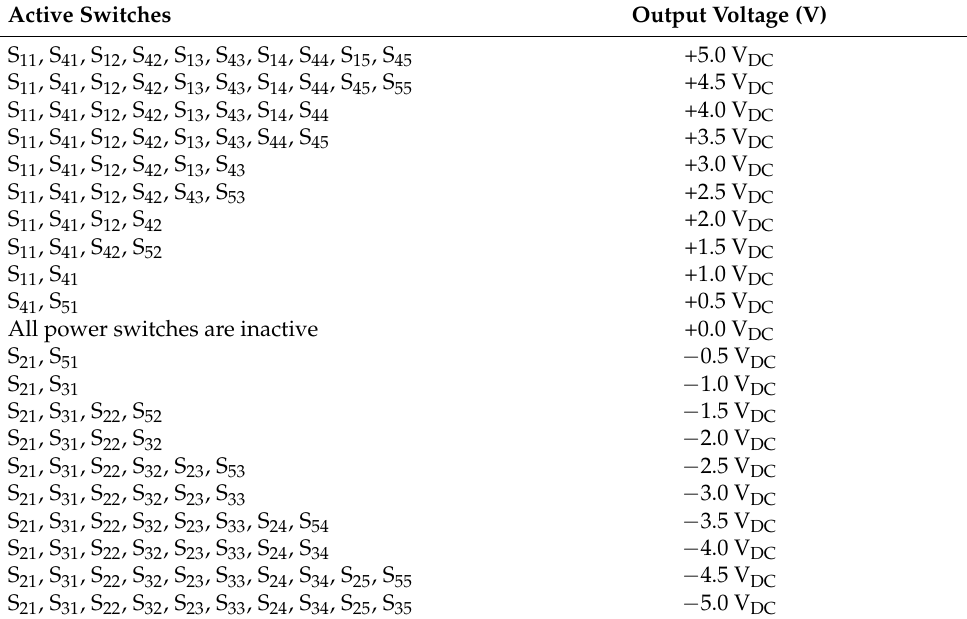
Table 1. Active power switches for a 21-level multilevel inverter for SHE modulation technique.